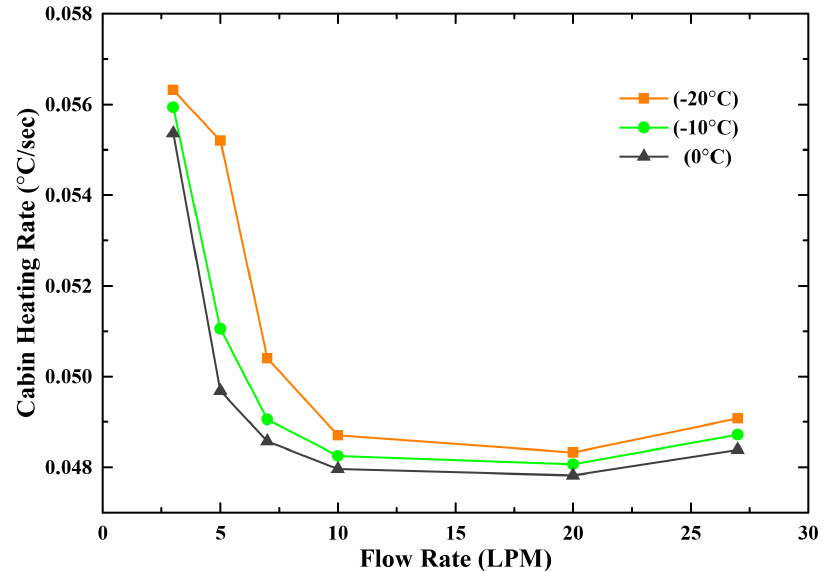
Figure 12. Cabin heating rate versus flow rate at 400 CMH airflow and heater capacity: 4